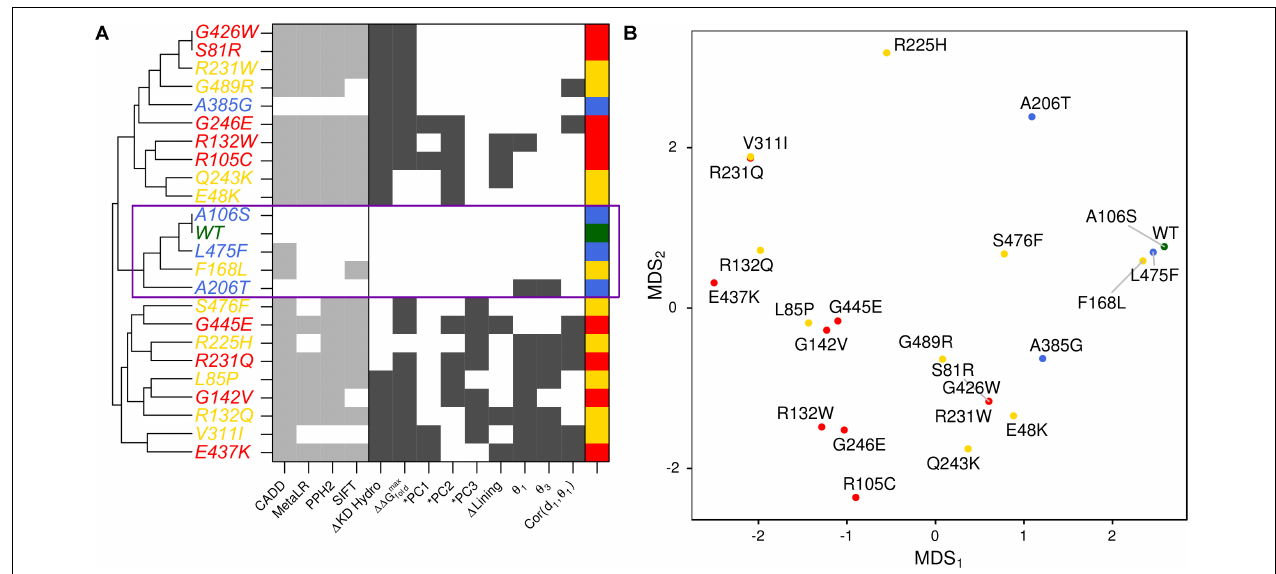
FIGURE 5 | Structure-based metrics discriminate pathogenic from benign variants and provide mechanistic hypothesis of altered function. (A) The most informative structure-based metrics presented in previous figures were discretized and compared to commonly used genomics-based predictive algorithms (see the section “Materials and Methods”). Metrics from both perspectives effectively discriminate between pathogenic and benign variants. However, structure-based metrics provide mechanistic hypotheses for how the protein is altered by each variant. Additionally, they indicate more variable effects for VUSs than genomics-based predictors. (B) We visualized the similarity of variants to one another using